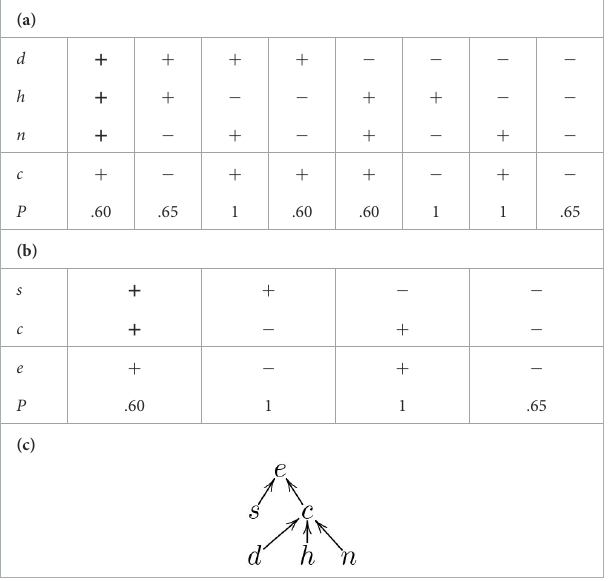
TABLE 2 An example of chained probabilistic classifier (CC) with (a) the first probabilistic classifier PC 1 with X 1 ={ d , h , n } , C 1 = { c } , and (b) the second probabilistic classifier PC 2 with X 2 = { s , c } , C 2 = { e } (both inputs highlighted in